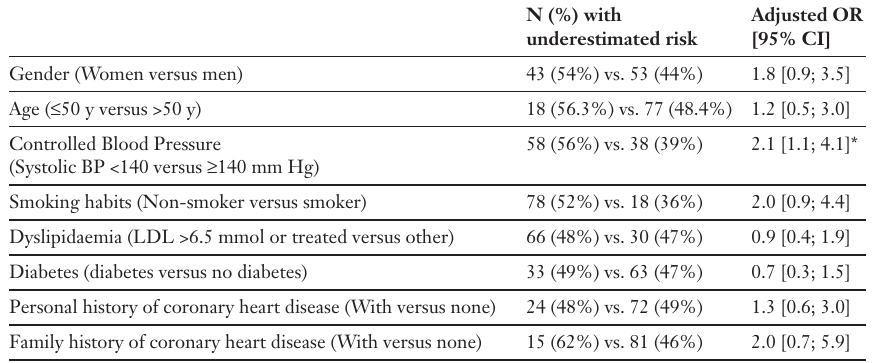
Table 3 Odds ratios of under- estimating cardio- vascular risks versus not underestimating them on usual pre- dictors for hyperten- sive patients. Logistic regression model was clustered for physicians (n =